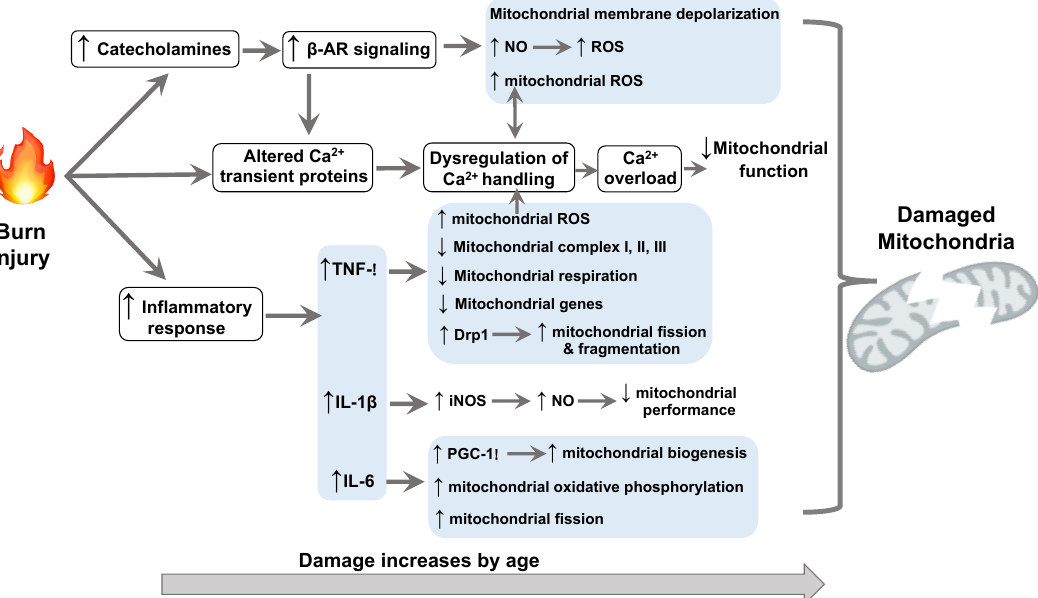
Figure 2. Schematic of potential molecular mechanisms underlying burn-induced cardiac mitochondrial changes. AR: adrenergic receptor; NO: nitric oxide; ROS: reactive oxygen species; Drp1: dynamin-related peptide 1; iNOS: inducible NO synthase; PGC: peroxisome proliferator-activated receptor-gamma coactivator.